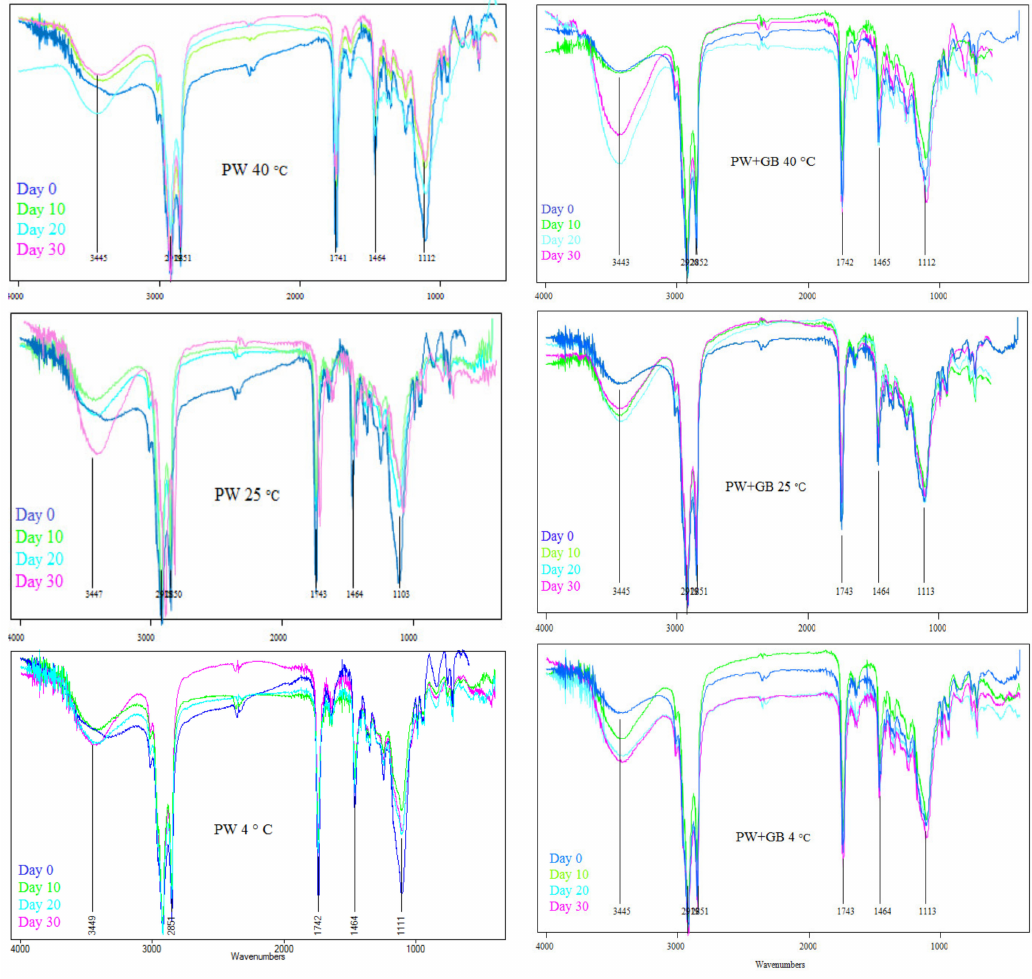
Figure 5. Oxidative stability of β -sitosterol NLC dispersions by Fourier Transform Infrared Spectrophotometry (FTIR) during storage at di ff erent temperatures (4, 25 and 40 ◦ C). PW and PW + GB represent the NLCs formulated with propolis wax alone or its binary mixture with glyceryl behenate (1:1),